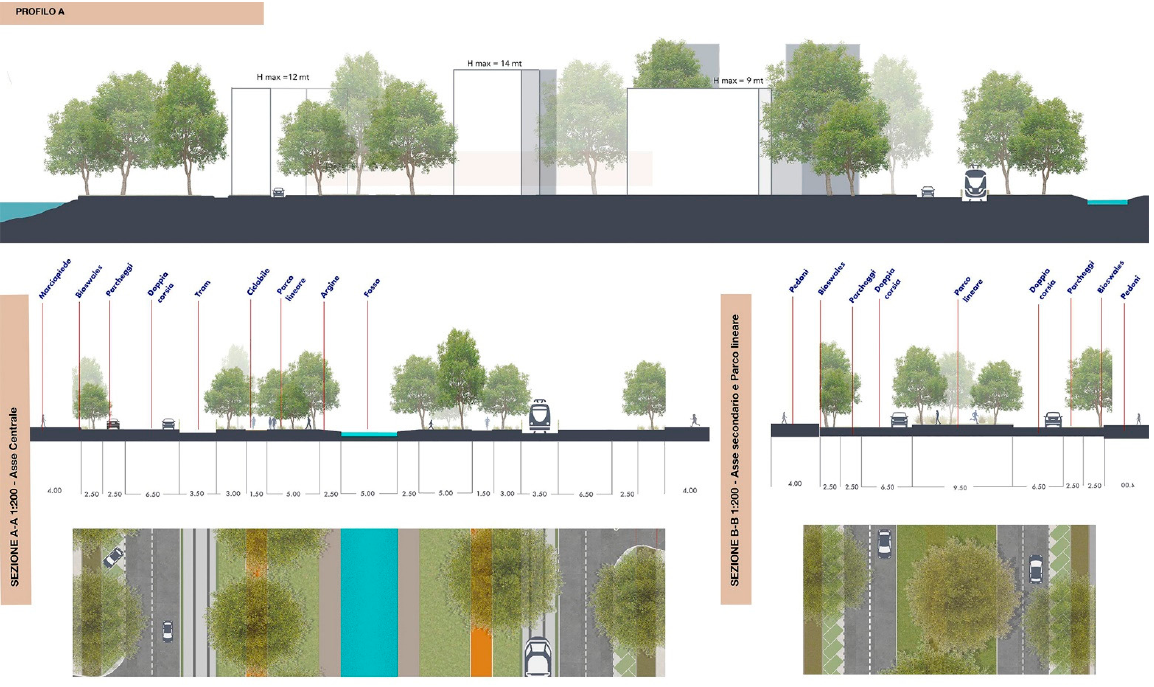
Figure 8. Rome Municipality X, Urban and Metropolitan Centrality Acilia–Madonnetta. Urban pro ‐ ject. Profiles. (Source: elaborations by the students: S. Maiorano, F. J. Moran, A. Musto, C. Paloni, Urban Planning Laboratory of the Faculty of Architecture of Rome A.A.